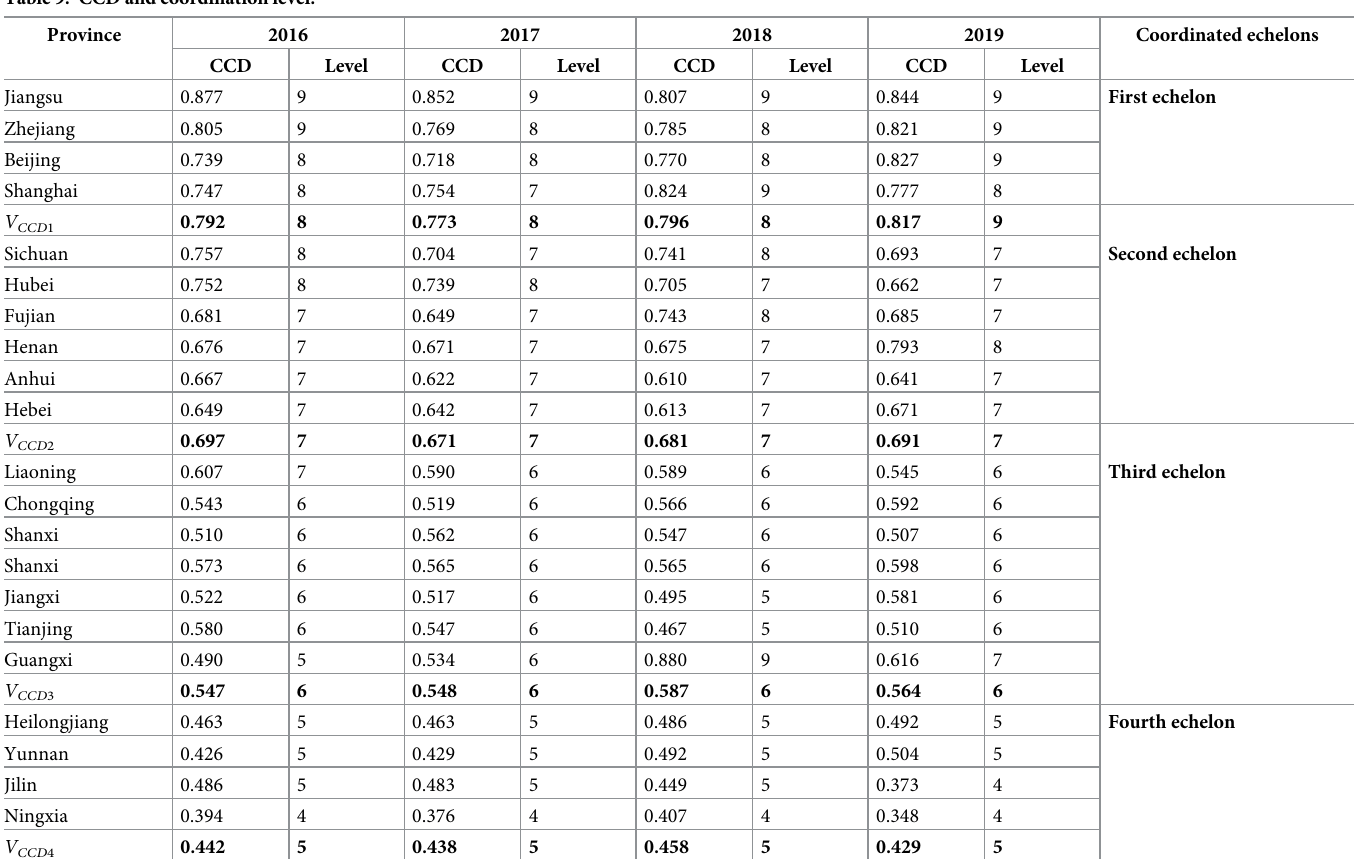
Table 9. CCD and coordination